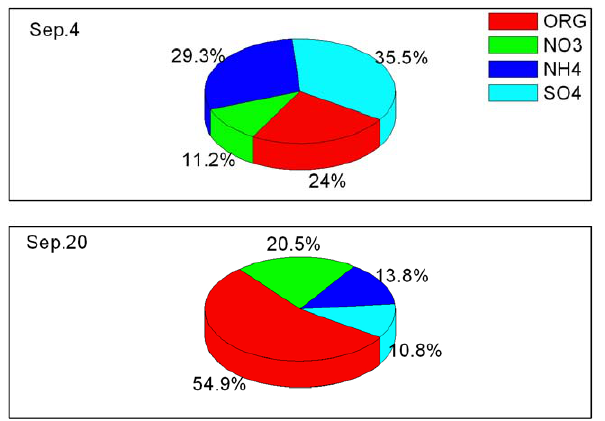
Fig.6 Closure between measured CCN number concentration and the CCN Number 3 Fig. 6. Closure between measured CCN number concentration and the CCN Number concentration calculated from aerosol number size distribution and Size-resolved activation for the three SS. concentration calculated from aerosol number size distribution and Size ‐ resolved 4 activation for the three SS 5